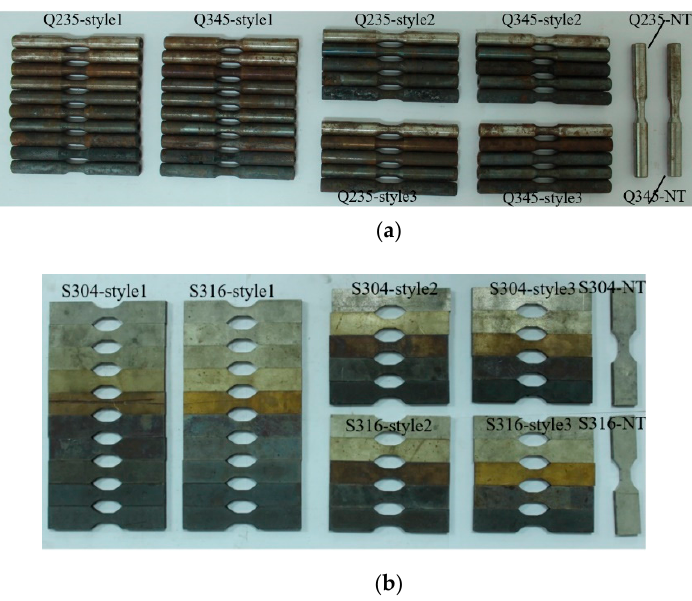
Figure 3. Prepared specimens. ( a ) Q235 and Q345; ( b ) S304 and S316.